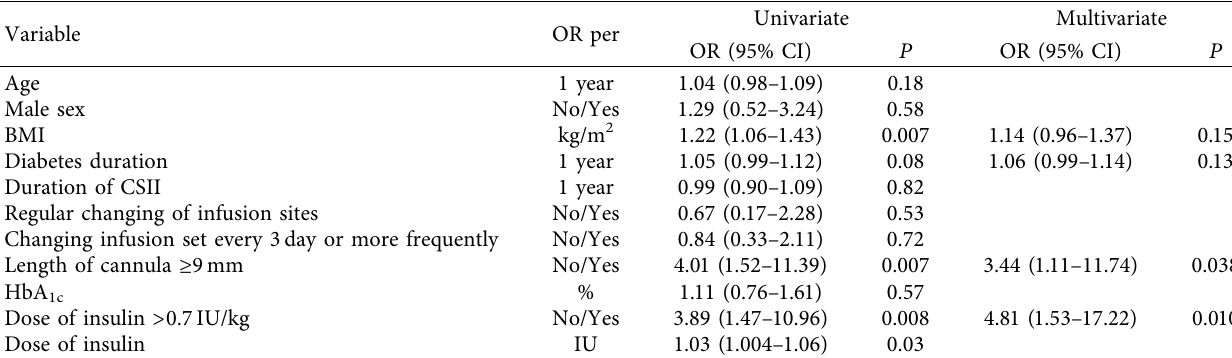
Table 3: Univariate and multivariate models for risk factors of advanced LH based on the authorial scale (6–8 points). Variable